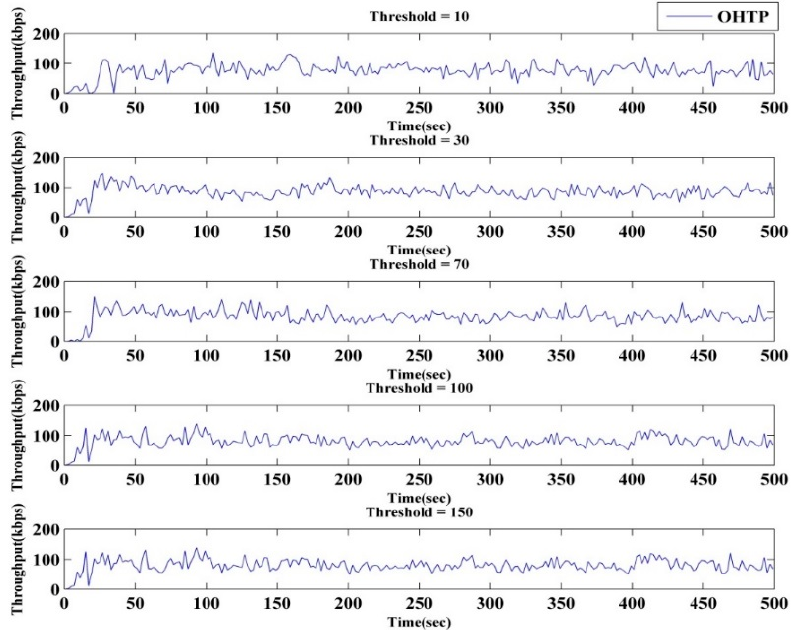
Figure 8. Optimum threshold value.